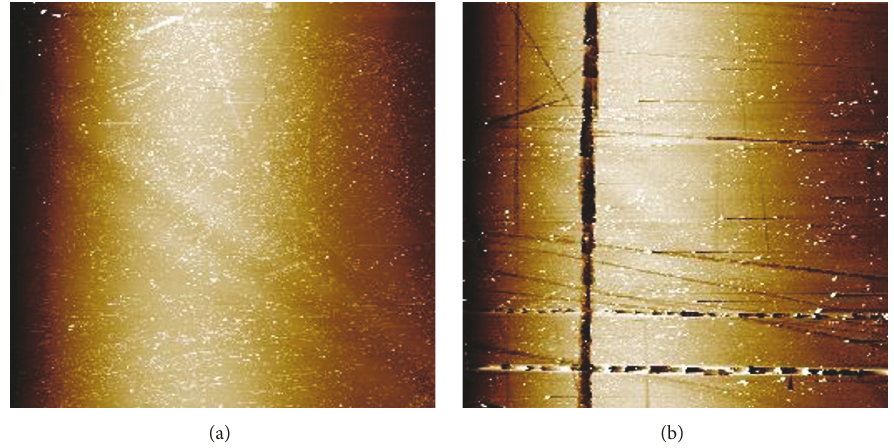
Figure 1: AFM (atomic force microscopy) image for an area of 50 𝜇 m × 50 𝜇 m. (a) Mica type V1 and (b) mica type V5.